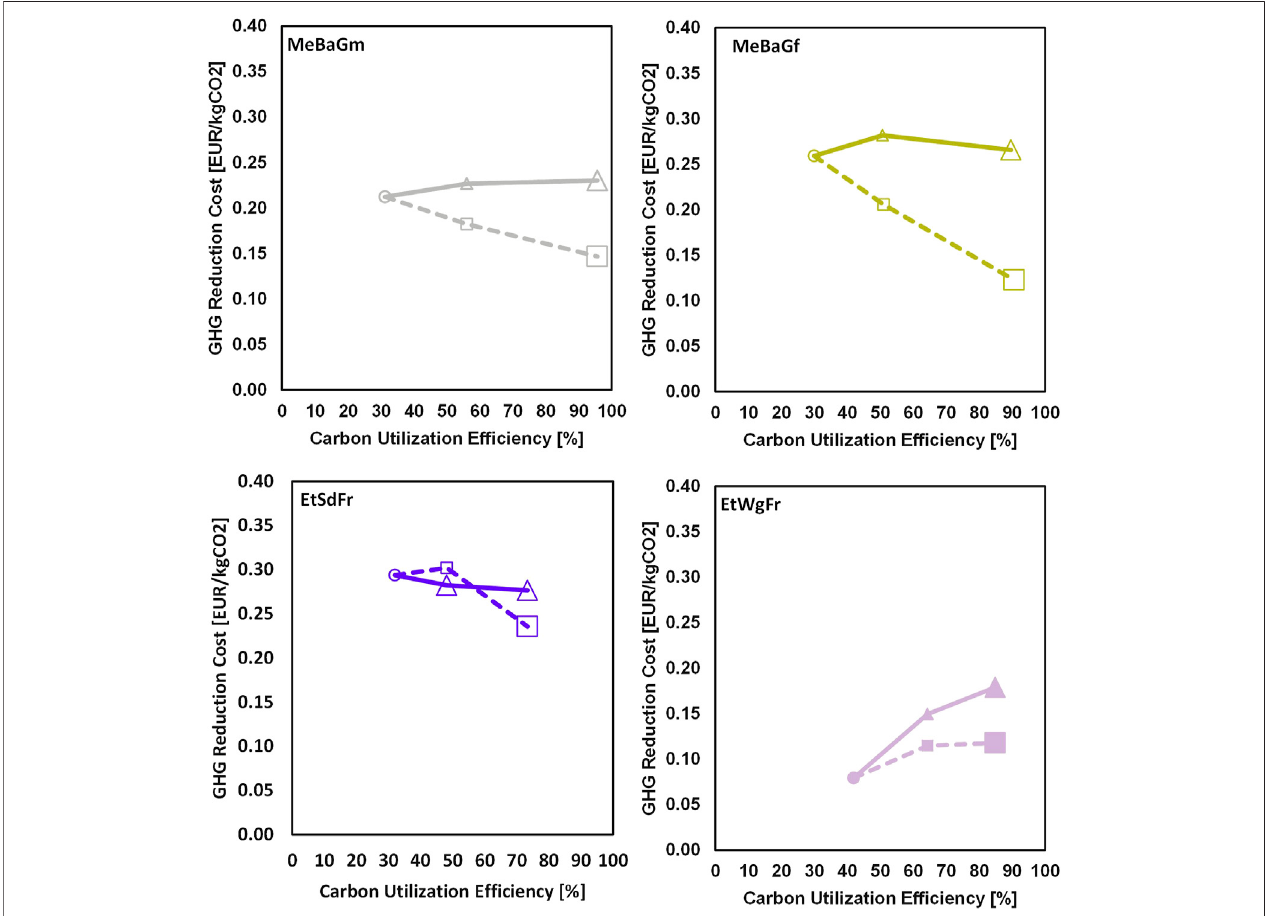
FIGURE 8 | GHG reduction cost with and without the capture of dilute CO 2 streams for MeBaGm (bio-methane from bark), DrBaGf (drop-in Fischer Tropsch biofuels from bark), EtSdFr (ethanol from sawdust) and EtWgFr (ethanol from wheat) under the CCS (dashed line, square) and CCU (solid line, triangle) options. Base option(leftmostmarkeroneach plot)ismarkedbycircles. Movingright, smaller markersshowresultswhenonlytheconcentratedCO 2 streamsarecaptured,and larger markers show results when CO 2 is captured from both concentrated and dilute streams. Emerging and commercial pathways are represented by empty and fi lled markers, respectively. See Table 1 for explanation of pathway